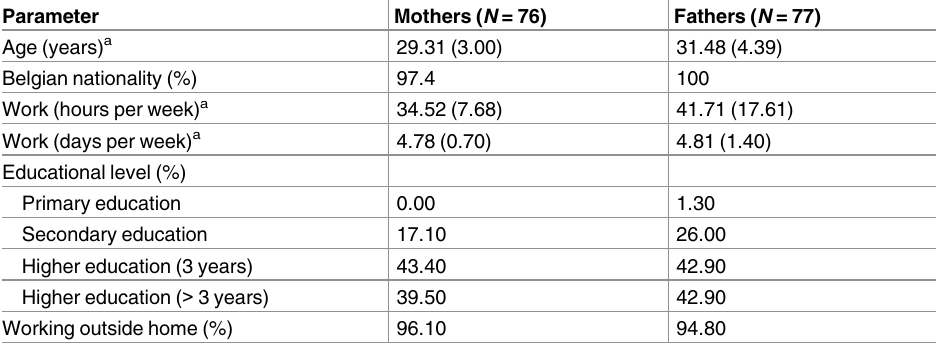
Table 5. Demographic features of mothers and fathers in Study